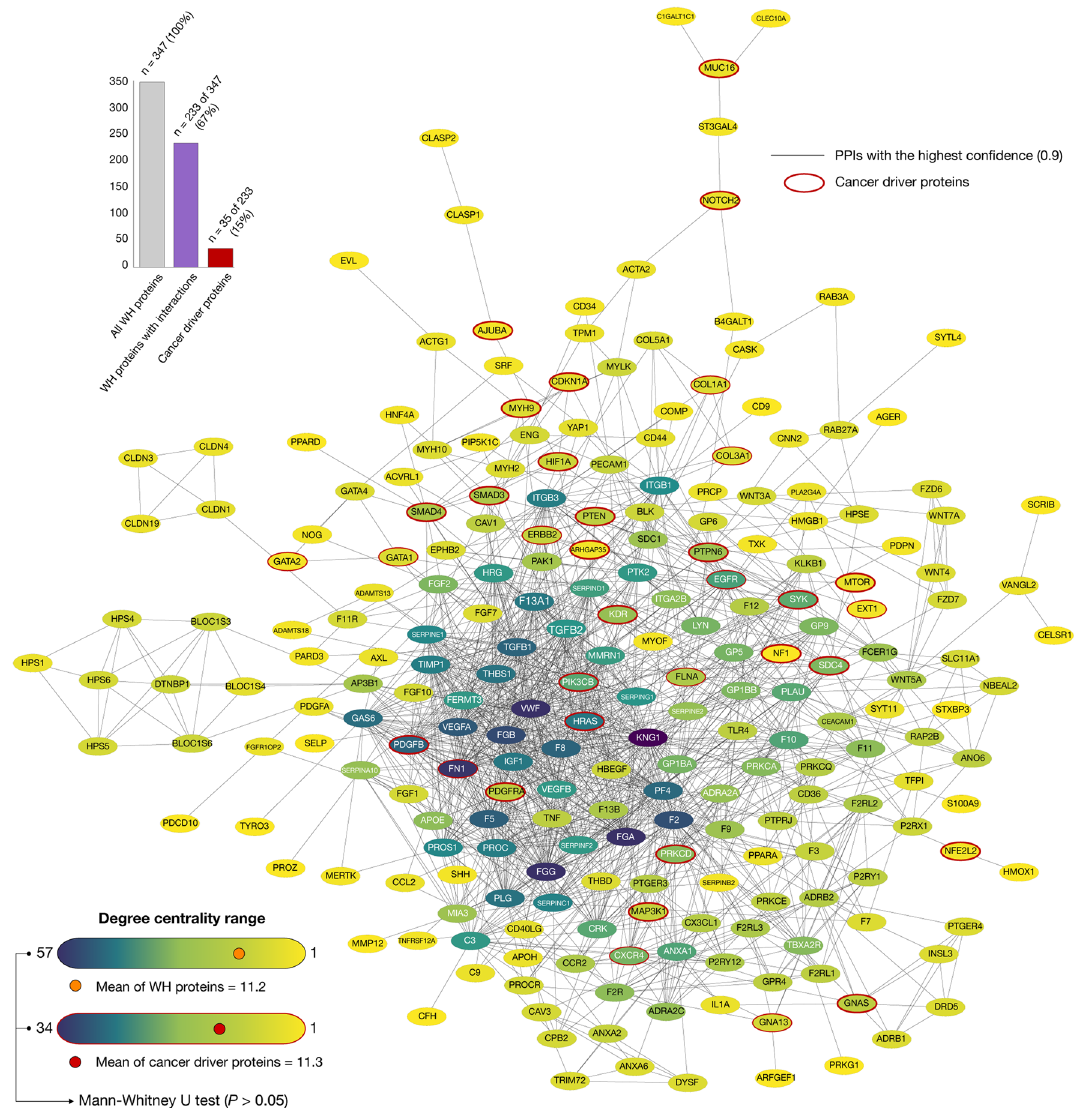
Figure 4. Wound healing protein–protein interactome network. Network of 233 wound healing proteins with at least one high confidence interaction (cutoff = 0.9). Darkest nodes represent proteins with the highest degrees of centrality (mean = 11.2). The WH-PPi network includes 35 cancer driver proteins with a degree centrality mean of 11.3. The Mann–Whitney U test showed a correlation of degrees of centrality between WH nodes and cancer driver nodes ( P > 0.05). Lastly, the WH-PPi network was visualized through the Cytoscape software v.3.7.1 34